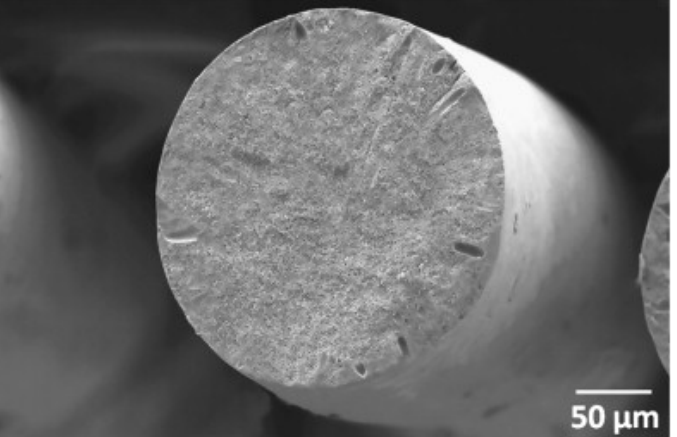
Figure 7. Scanning electron microscopy (SEM) images of the cross-section of the pregelled gel-spun fiber (reprinted with permission from [74] , copyright 2011 Elsevier).